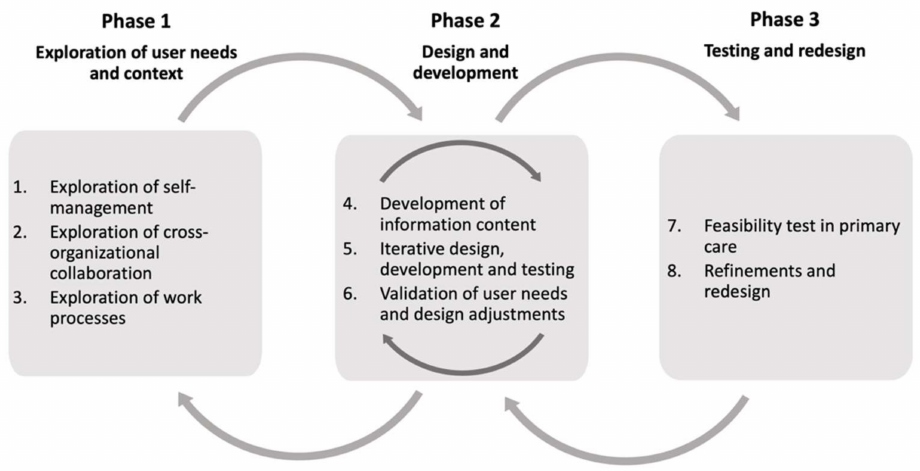
Figure 1. Overview of the three study phases and steps numbered 1–8. The arrows between and within design phases illustrate iteration in the design process. In particular, steps 6 and 8 link the three phases through